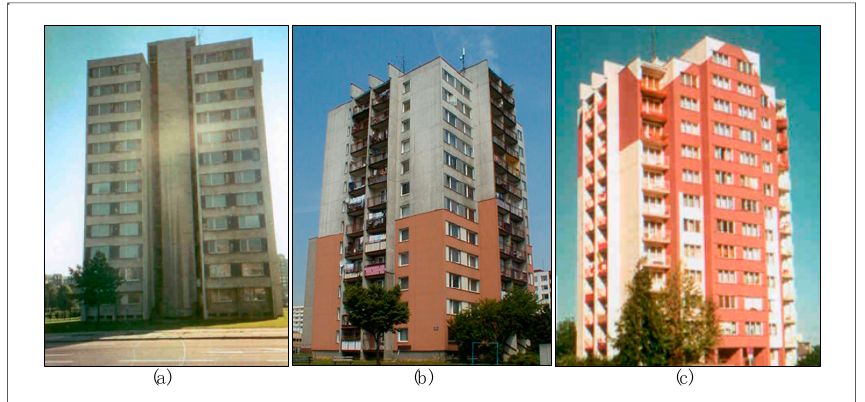
19 of 21 Figure A3. Prefabricated residential housing buildings after the renovation intervention by ETICS: